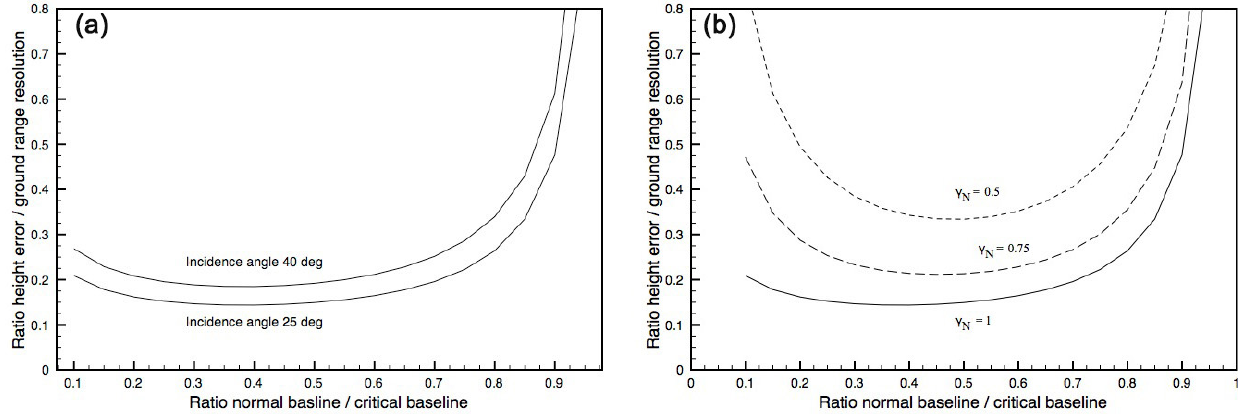
Figure 1. Relative height error normalized by ground range resolution as a function of the ratio between normal and critical baseline, shown for (a) γ N = 1 and two incidence angles and (b) for an incidence angle of 25 ◦ and different values of noise